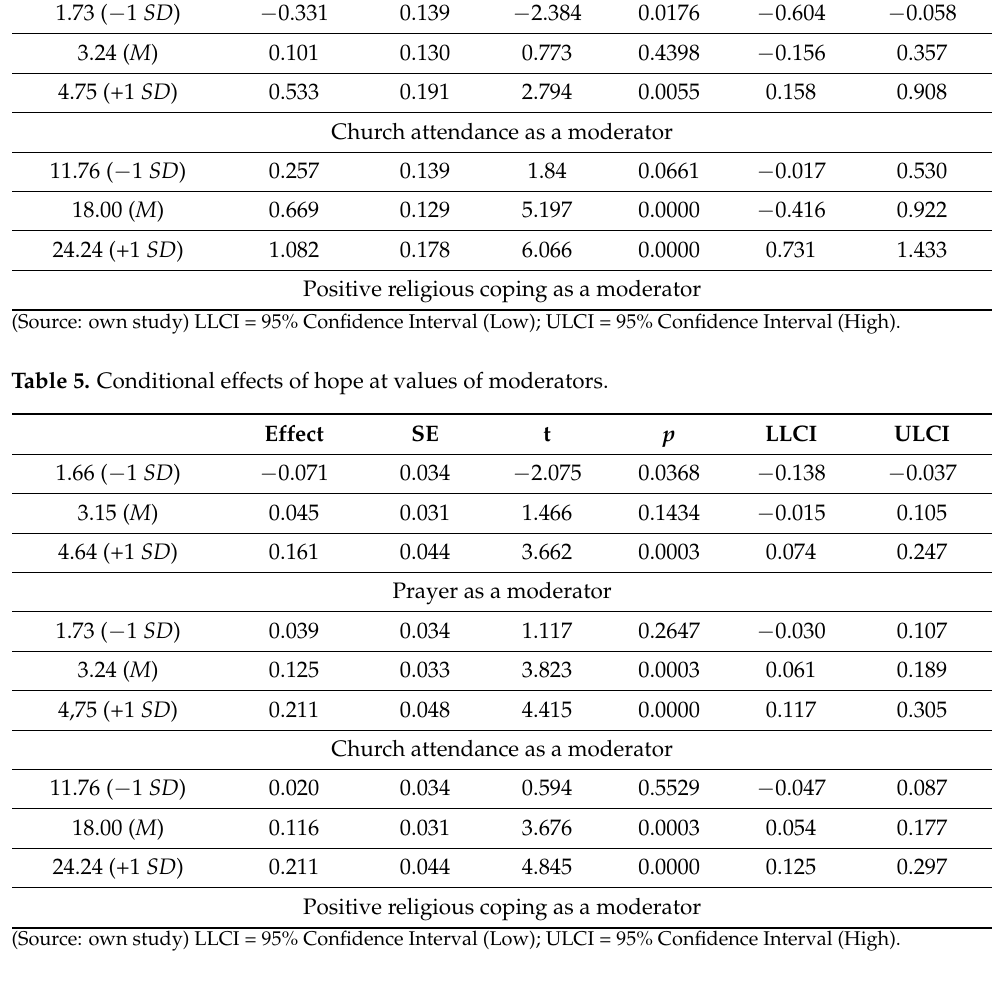
Table 6. Conditional effects of gratitude at values of moderator (positive religious